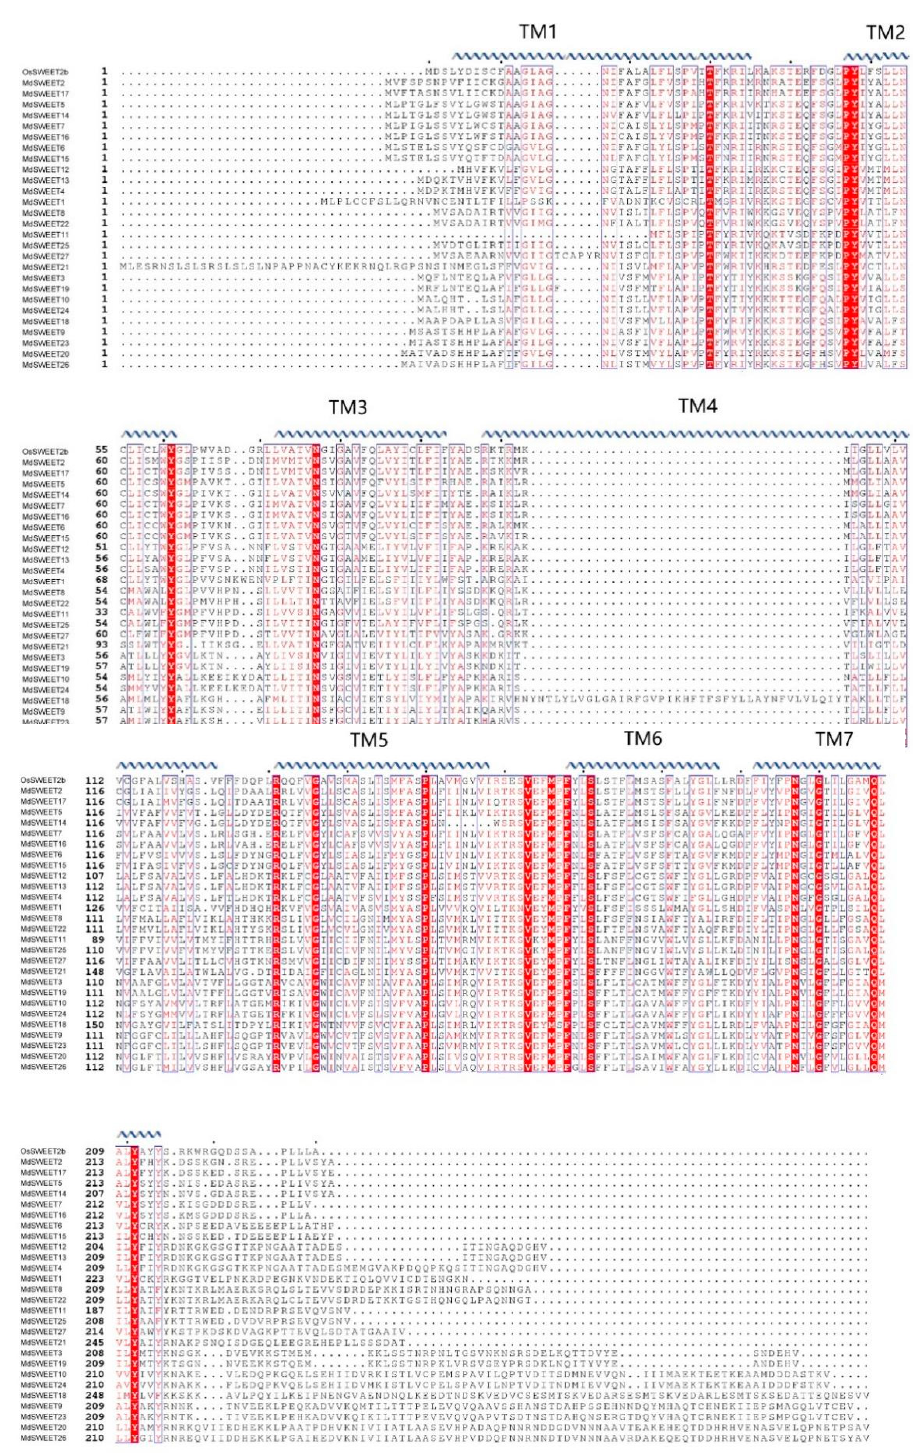
Figure 1. Sequence alignment of MdSWEETs and OsSWEET2b. Sequences of SWEETs were aligned using Clustal X2, and the results were submitted to the Essprint online website (https://espript.ibcp.fr/ESPript/cgi-bin/ESPript.cgi/ (accessed on 10 December 2020)) for visualization. Based on the OsSWEET2b structure, the positions of the seven transmembrane (TM) structural domains (TM1 to TM7) are indicated by wavy lines above the sequence. Conserved amino acid sequences are indicated in red.